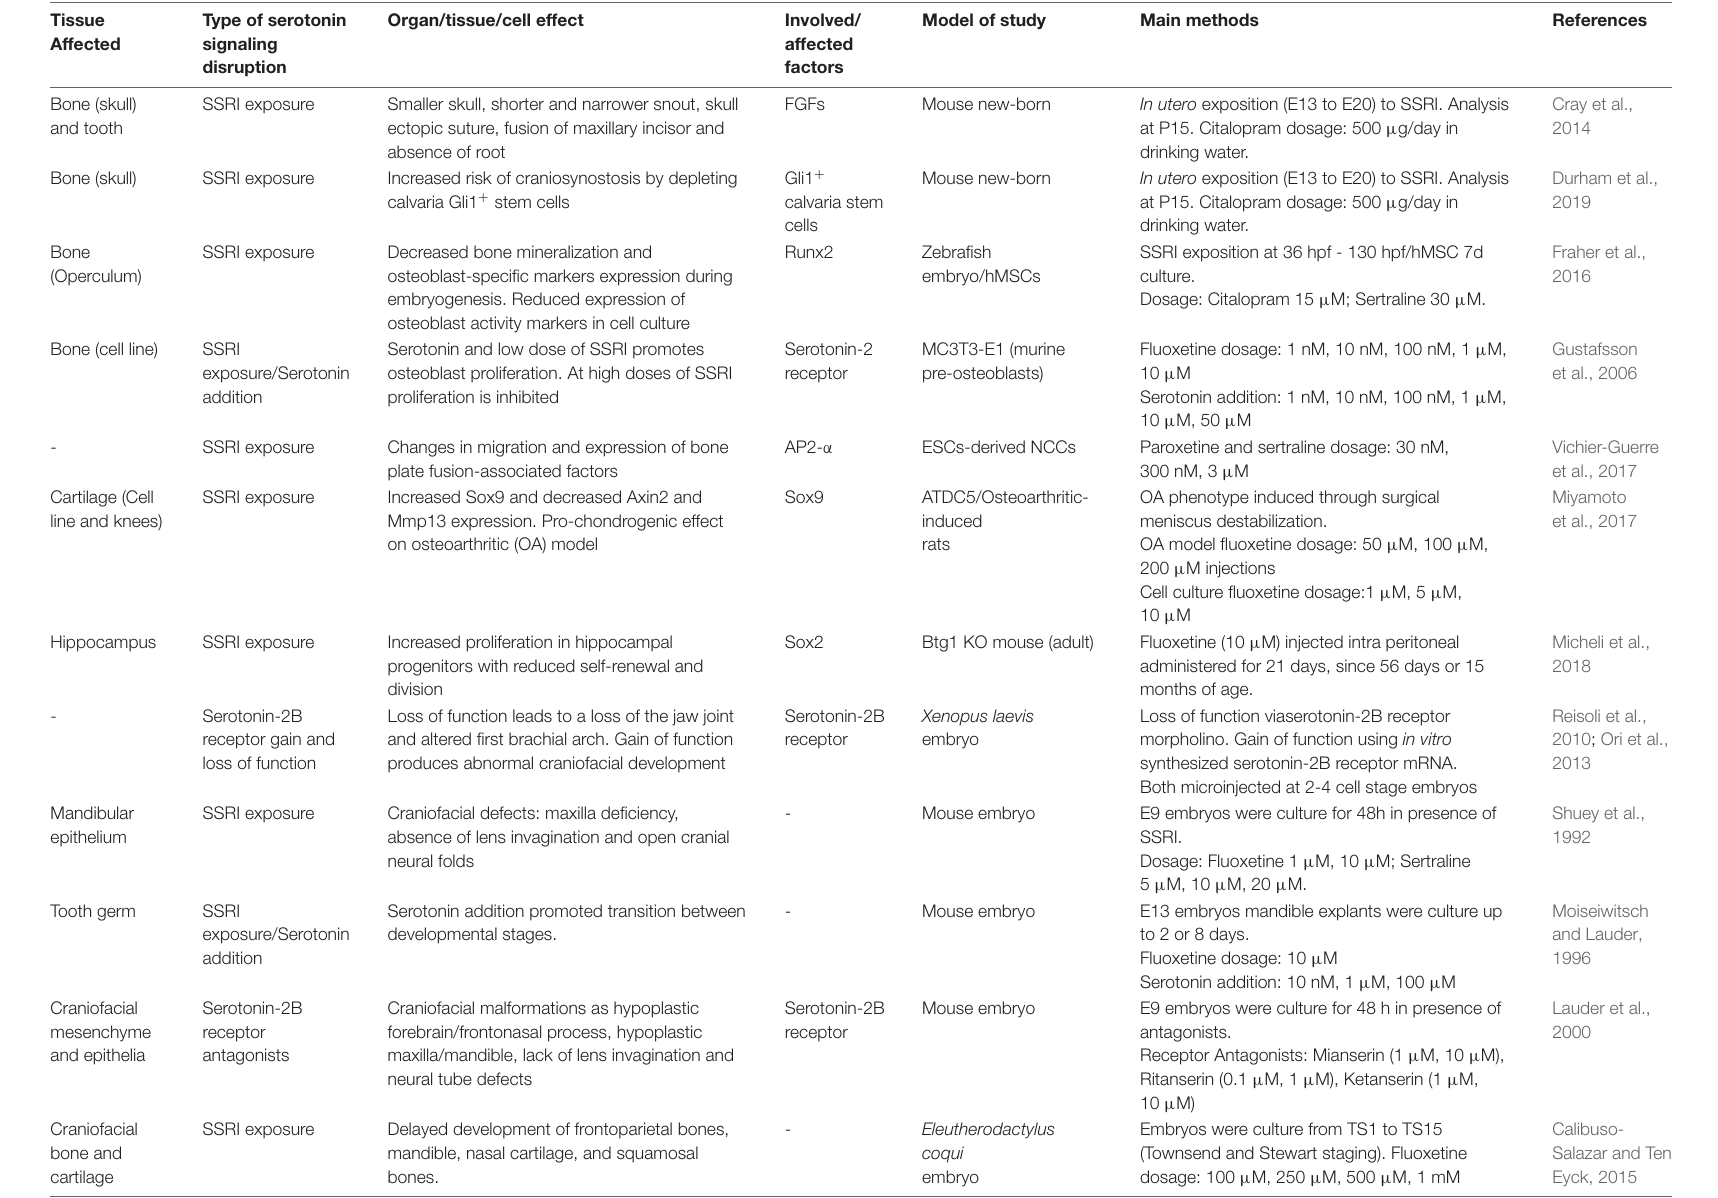
TABLE 1 | Summary of main findings of research relating serotonin signaling pathway disruption and craniofacial development related effects.